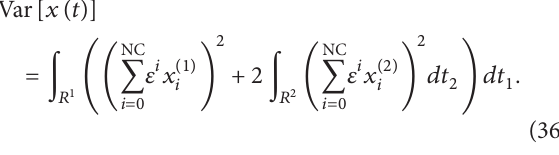
on the response variance is negligible. The multiplication of 𝑒